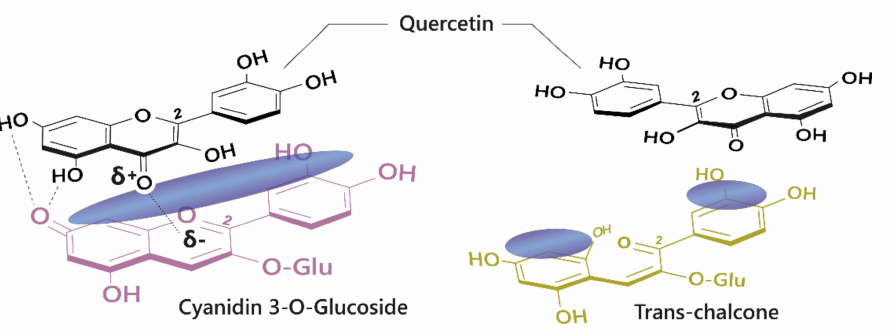
Figure 2. Left: Co-pigmentation interaction between cyanidin 3- O -glucoside and quercetin. Blue clouds above the structures denote polarisable surface area. Direct electrostatic interactions form between substituent groups, stabilising the coloured species. Right: Ring opening breaks the conjugated system across the tricyclic ring, reducing the planar surface for co-pigmentation.